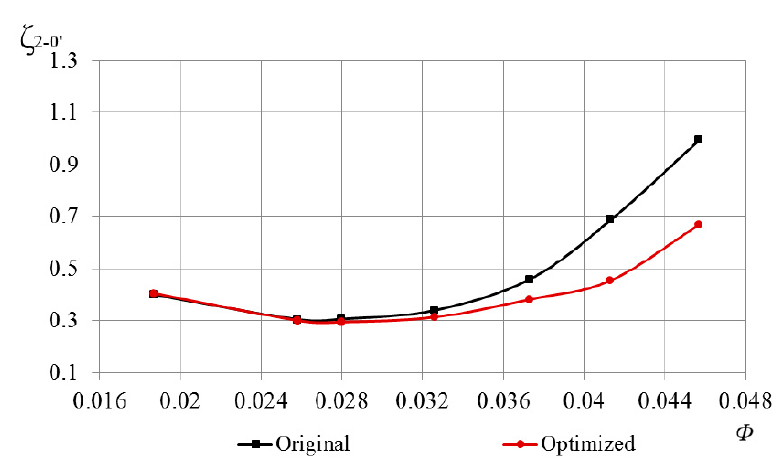
Figure 2. Return channel loss coefficient (ASNSYS CFX) [10].